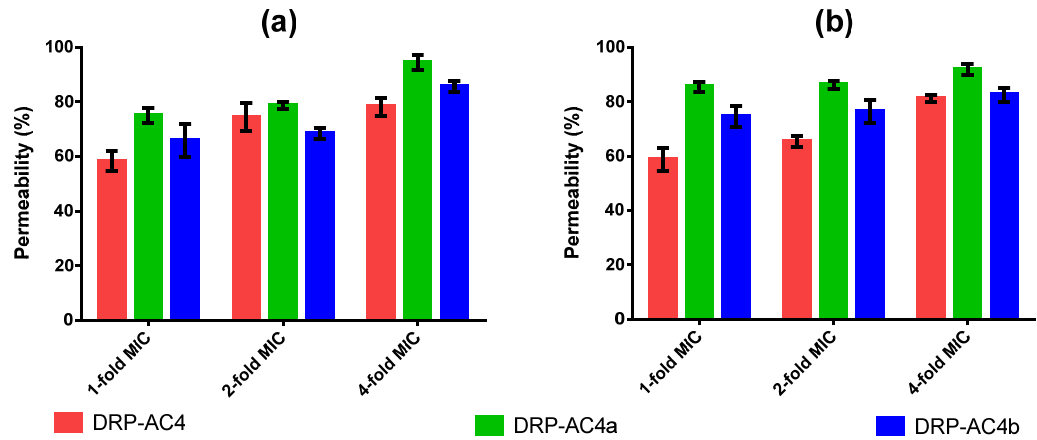
Figure 8. The destruction of S. aureus ( a ) and C. albicans ( b ) cell membranes at concentrations of 1-fold, 2-fold and 4-fold MICs. The error bar represents the SEM of fifteen replicates.